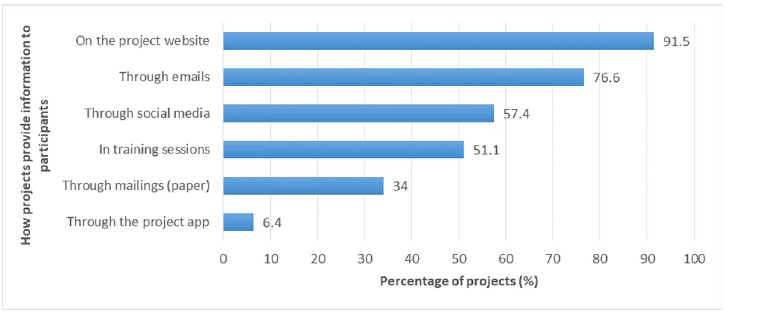
Fig 6. Means of providing information to the project participants.